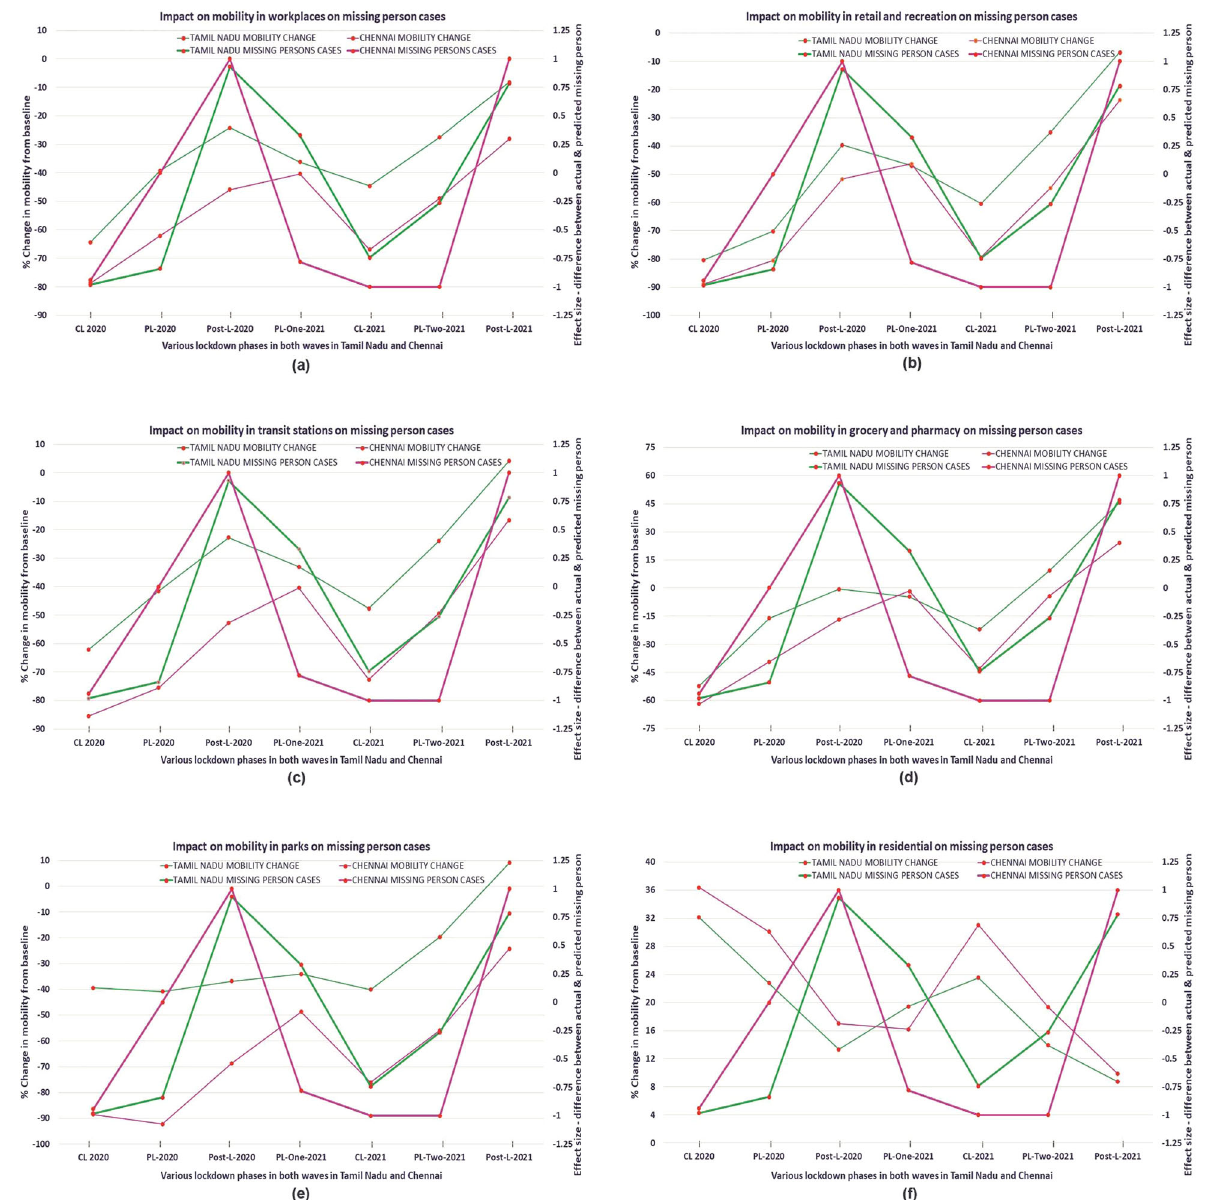
Fig. 9 Impact of mobility on registered cases of missing person during pandemic. Relationship between mean percentage change in mobility from baseline and difference between actual and predicted of missing person cases (effect size-Cliffs Delta) — six spatial domains — Tamil Nadu and Chennai. Panel (left): a , c , e Workplace, Transit stations and parks (Mobility vs. effect size (difference between actual cases registered and predicted, expressed as Cliffs delta). Panel (right): b , d , f Retail and recreation, grocery and pharmacy, residential (Mobility vs. effect size (difference between actual cases registered and predicted, expressed as Cliffs delta). x -axis — discrete intervals showing various lockdown phases (CL is complete Lockdown, PL is partial lockdown, and Post-L is post-lockdown). y -axis (left) — shows the mean percentage change in mobility from baseline in different community spaces. y -axis (right) — shows the Cliffs delta, a measure of effect size (difference between the actual and predicted cases of registered missing person cases in Tamil Nadu and Chennai) across all spaces and in various lockdown